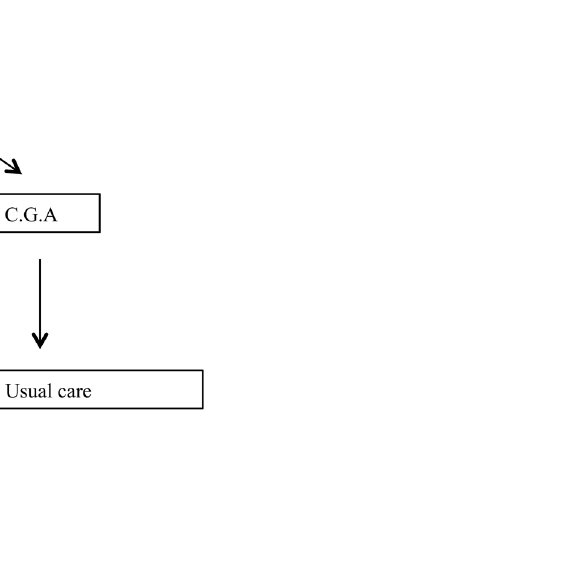
PLOS ONE | DOI:10.1371/journal.pone.0149732 February 26,